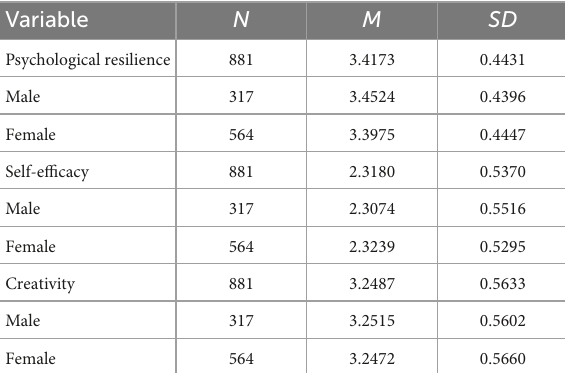
TABLE 1 Descriptive statistics for the three